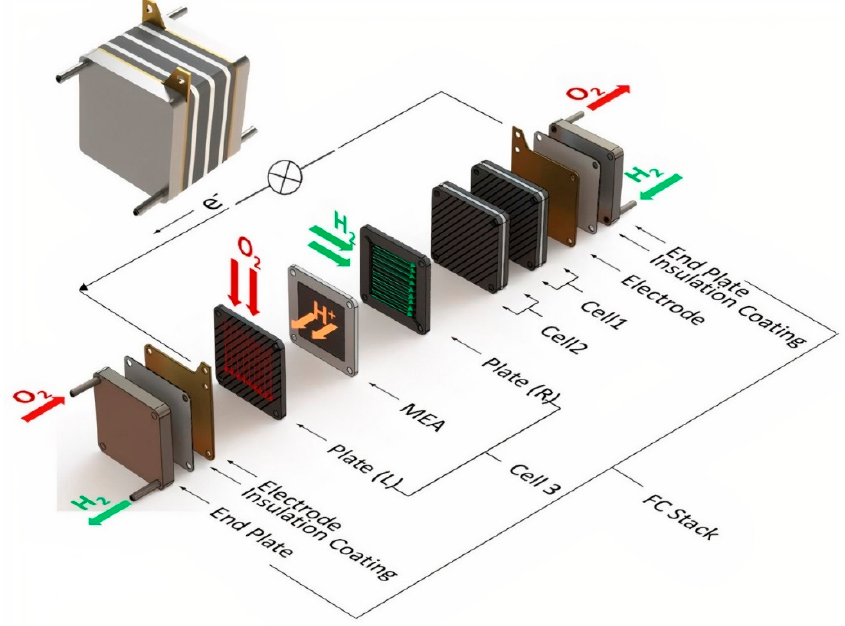
Figure 7. Fuel cells stack and components schematic [140]. (With permission, license number: 5430310482582).